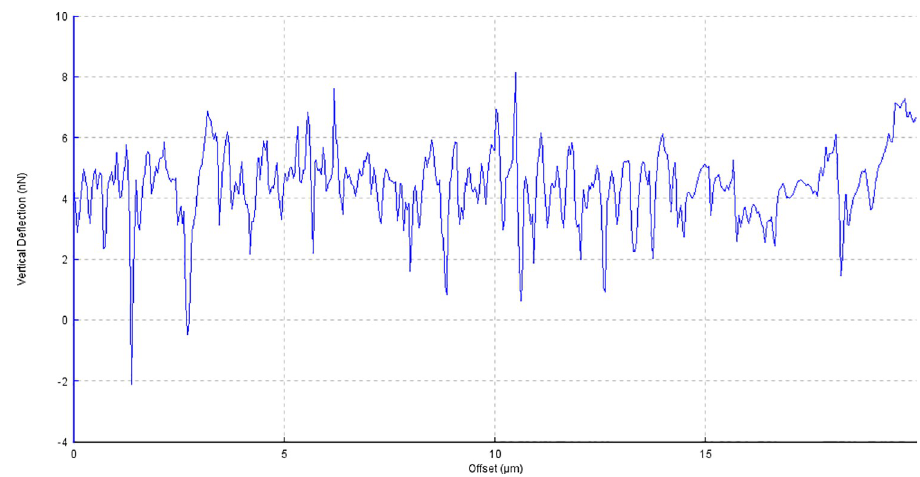
Fig 4. Example image of corneal surface treated with FS1 with AFM line profile.